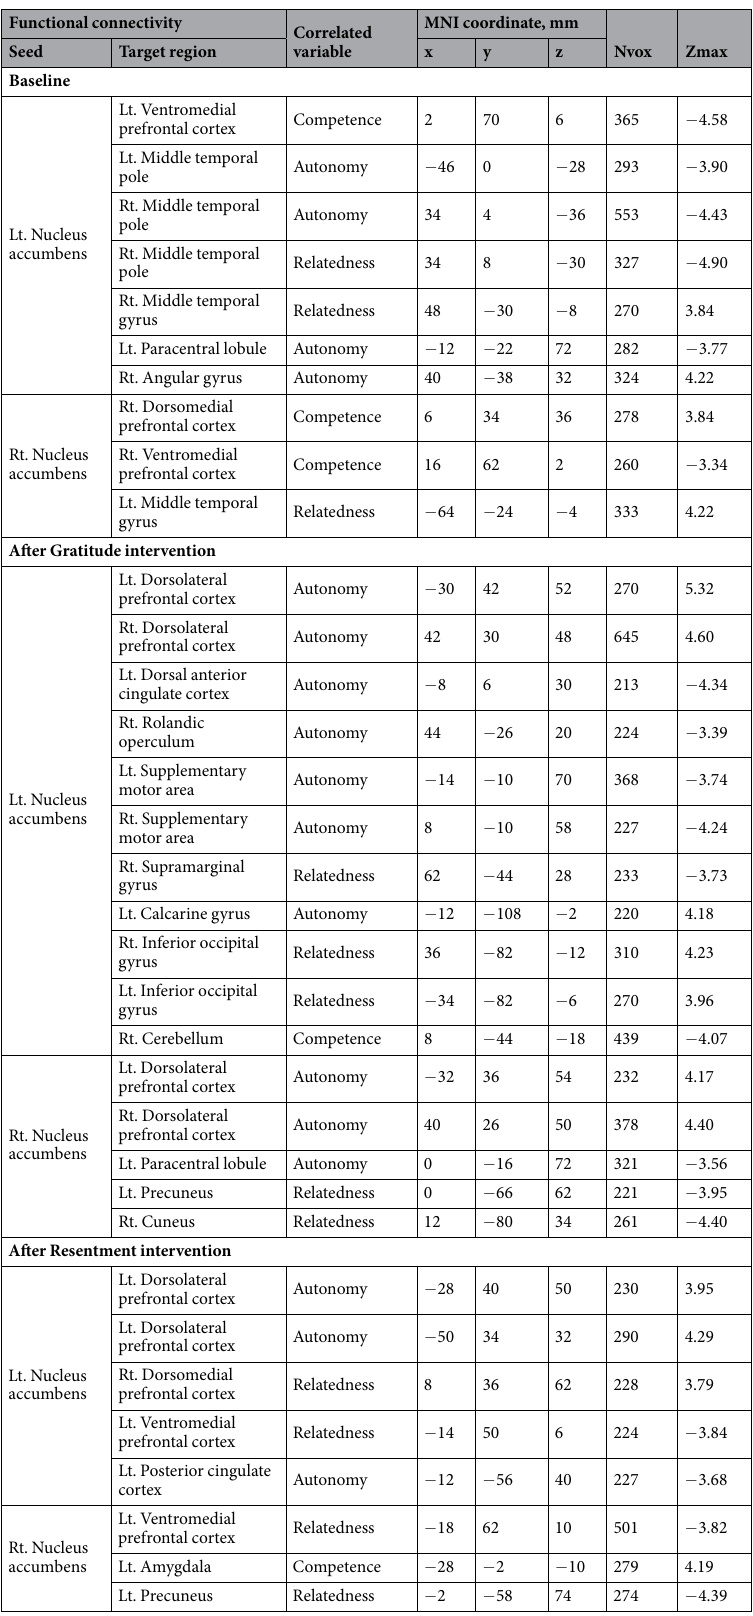
Table 3. Relationships between nucleus accumbens-based functional connectivity and the subscale scores of self-determination theory such as autonomy, competence, and relatedness. Significant clusters were obtained at family-wise error rate corrected P < 0.05. Abbreviation: Lt, left; MNI, Montreal Neurological Institute; Nvox, number of contiguous voxels; Rt, right; Zmax, maximum z-value within the